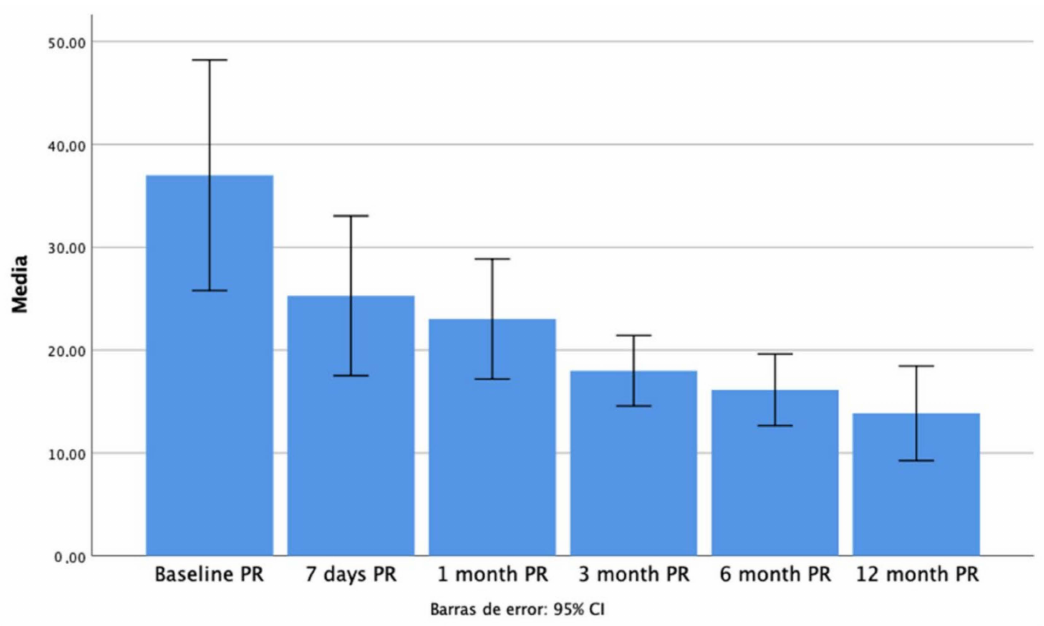
Figure 2. Bar chart for PR values at each follow